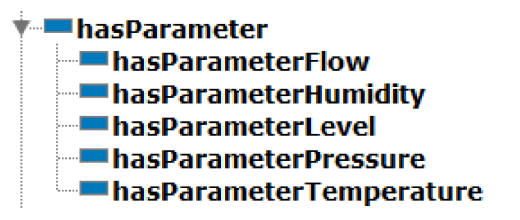
Figure 7. Element module inverse